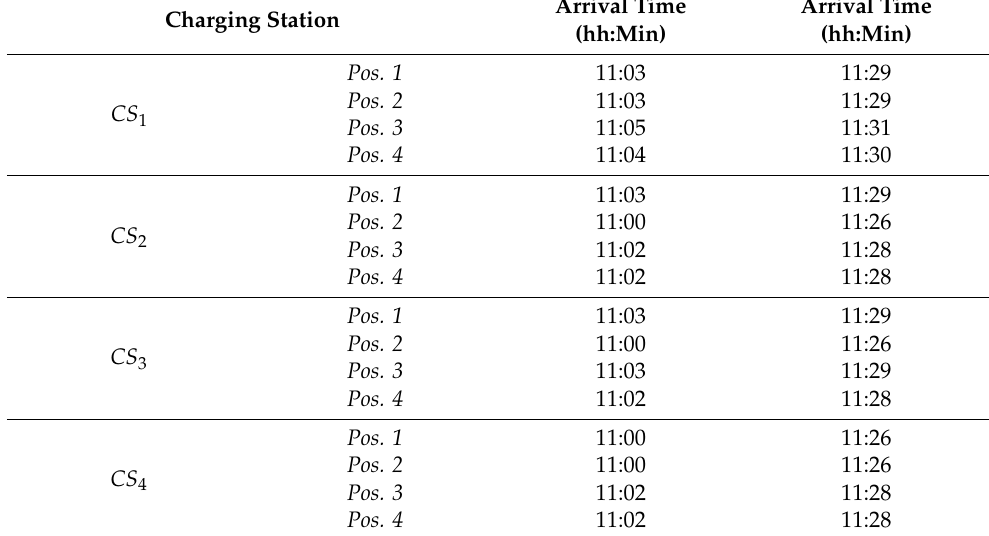
Table 2. Arrival time of the PEVs.